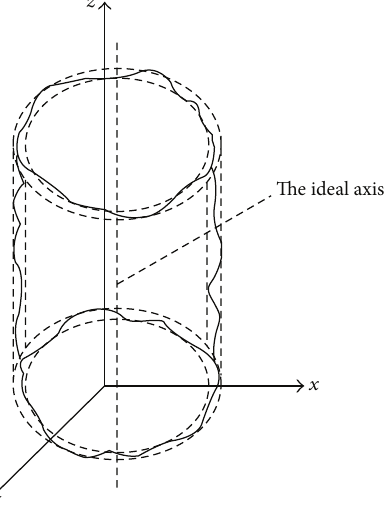
Figure 5: The minimum zone